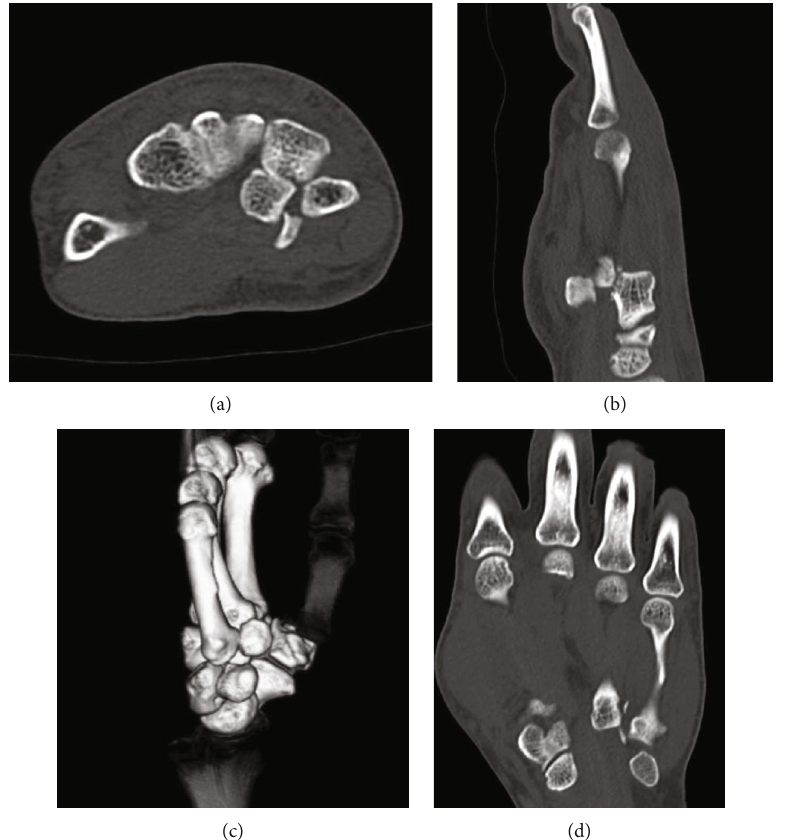
Figure 2: CT scan showing the carpometacarpal bases incarcerated at the fracture gap of the hamate hook at the fracture site. (a) Axial view. (b) Sagittal view. (c) Three-dimensional view of the hand. (d) Coronal view of the CT scan also shows the avulsion fracture between the base of the fourth and fi fth metacarpal